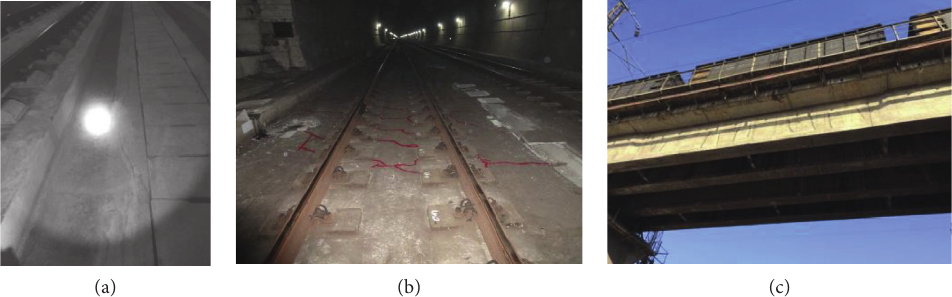
Figure 1: Typical structural diseases: (a) faulting crack in fill layer of tunnel bottom; (b) minor cracks in tunnel rail plates; (c) vertical crack in beam